Question: Identify the chart type used in this figure.
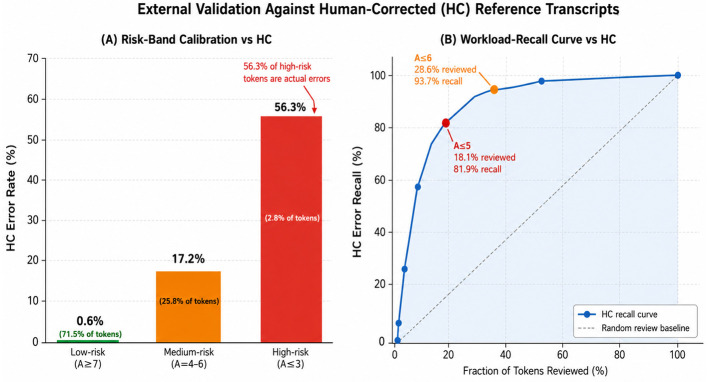
Answer: bar